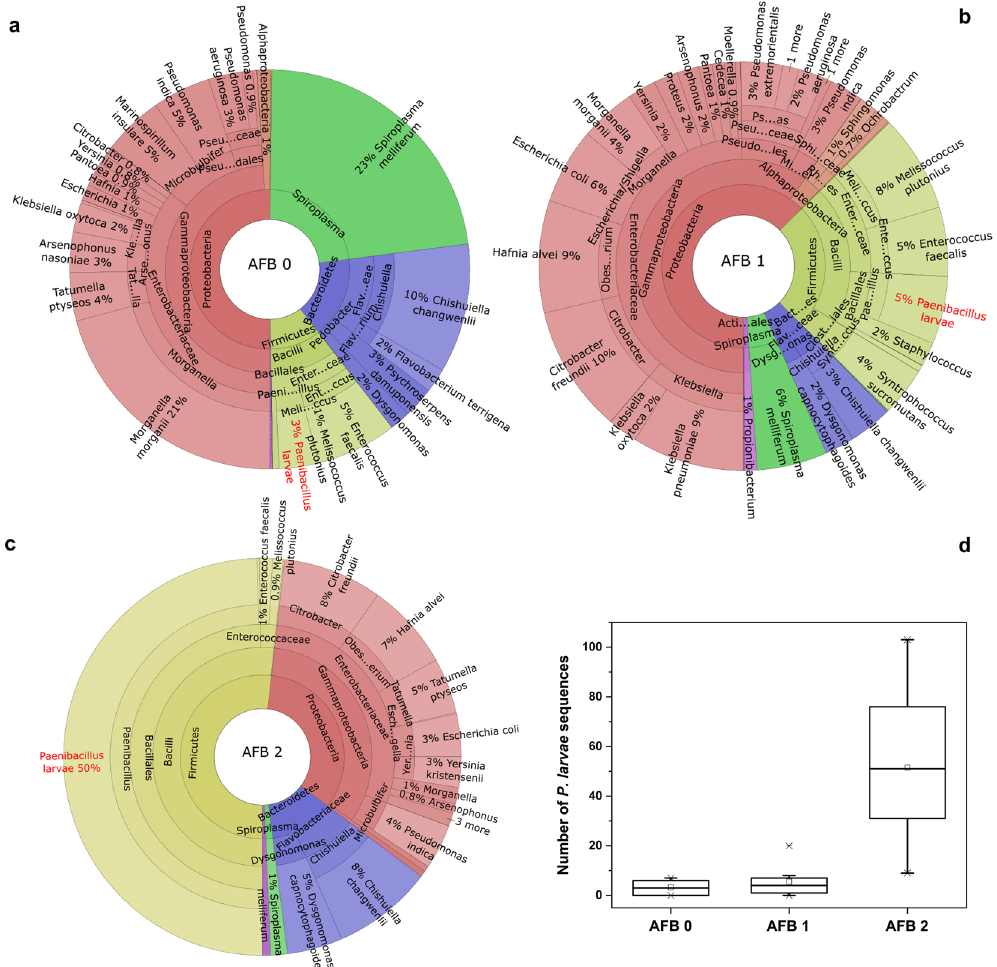
Figure 1. Krona projections of the microbiome of honeybee workers based on analyses of the parasitic/ environmental portion of the microbiome and comparison of P. larvae sequence numbers. Paenibacillus larvae is shown in red. Legend: ( a ) AFB0: control bees from outside the AFB zone with no signs of AFB, ( b ) AFB1: bees from asymptomatic colonies in AFB apiaries, ( c ) AFB2: bees from colonies exhibiting clinical symptoms of AFB, ( d ) comparison of the number of P. larvae sequences.